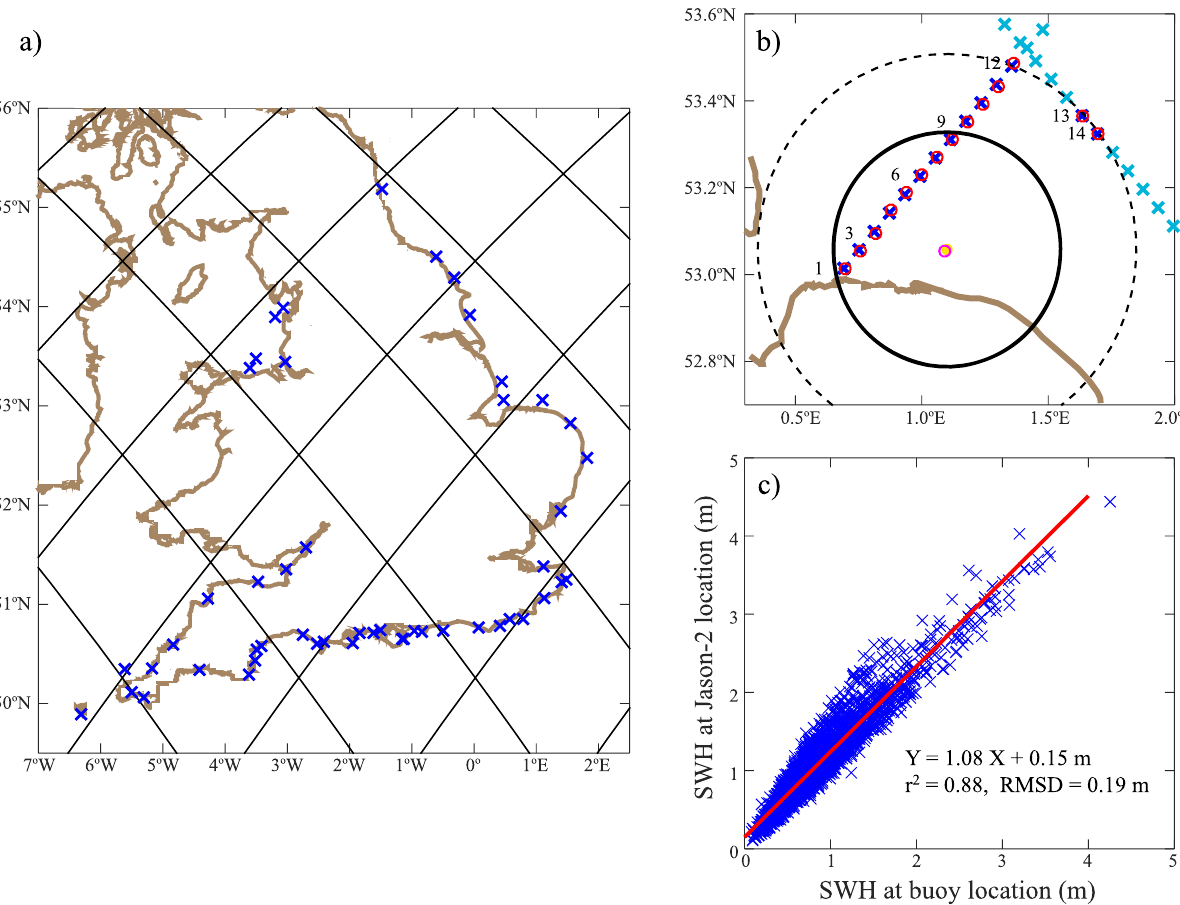
Fig. 7 Regional validation against coastal buoys. a Jason-2 tracks overlaid on map of the 50 coastal wave platforms curated by the Channel Coastal Observatory. b Zoom over region of Blakeney Overfalls buoy (orange star) off East Anglia, with nominal points along two Jason-2 tracks shown by light blue crosses. The concentric circles indicate 50 km and 30 km from the buoy, with dark blue crosses indicating those within 50 km. The red and magenta circles indicate the centres of the corresponding model points. c Linear regression of Signi fi cant Wave Height (SWH) values from reanalysis at altimeter point 9 (y-axis) against reanalysis values at the buoy 2. Ordinary least squares estimation of the model ϵ t = ρ ϵ t − 1 + e in order to estimate the parameter ρ , which is related to the fi rst order autocorrelation